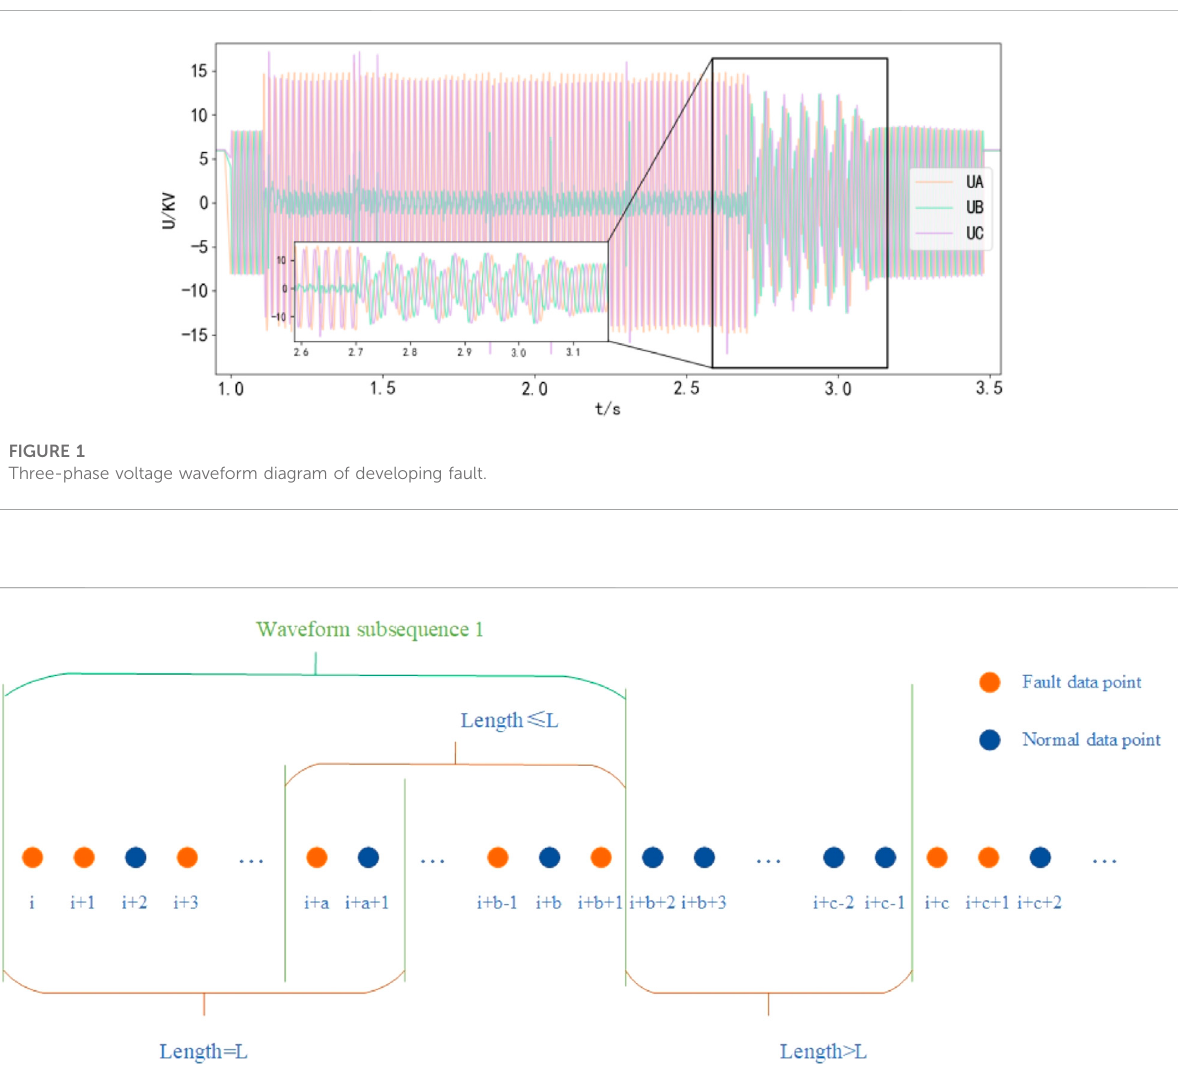
FIGURE 2 Schematic diagram of waveform subsequence